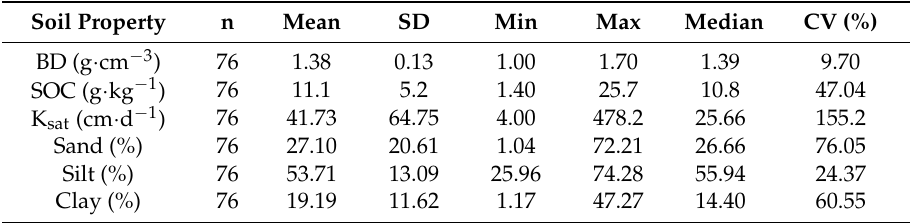
Table 1. Descriptive statistics of selected soil properties within the entire floodplain transect.